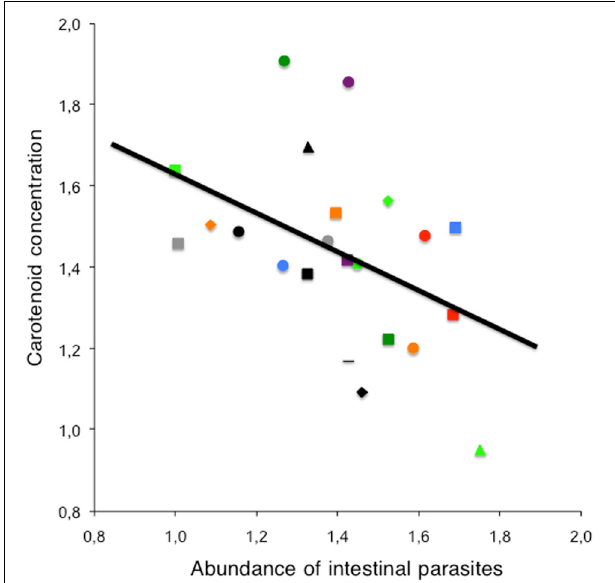
FIGURE 3 | Carotenoid concentrations and parasites. Relationship between the abundance of intestinal parasites and carotenoid concentrations ( μ g/ml) at interspecific level (see legend of Figure 1 to identify the data from each